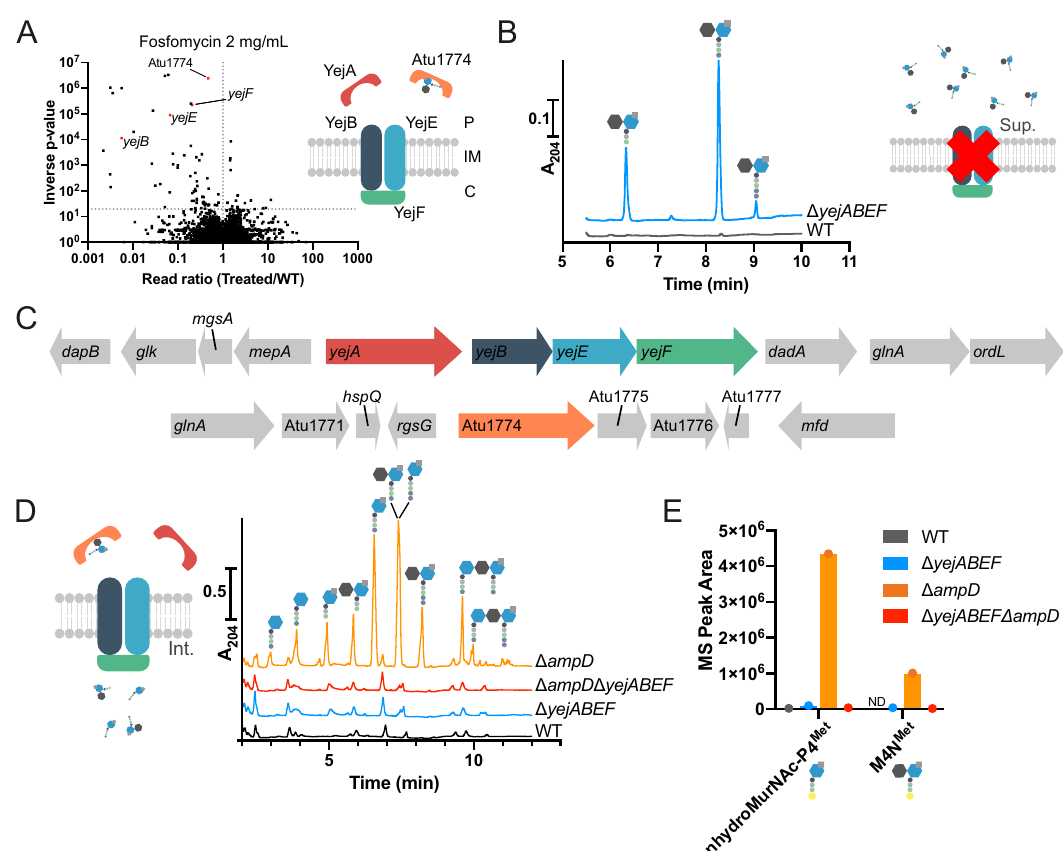
Fig. 2 | YejBEF is the PG recycling transporter in A. tumefaciens . A Volcano plot showingtheratioofTransposonsequencing(Tn-Seq)readsmappedtogenesinthe A. tumefaciens WT strain treated with 2mg/mL Fosfomycin compared to control, plotted against inverse p value determined by Mann – Whitney U test (threshold p − 1 >20).Genescorrespondingto yejBEF andAtu1774arehighlightedinthevolcano plot in red; their localisation in the schematic is determined by their annotation as periplasmic substrate-binding proteins, membrane-spanning proteins or cyto- plasmic ATPase. C, cytoplasm. IM, inner membrane. P, periplasm. B UPLC